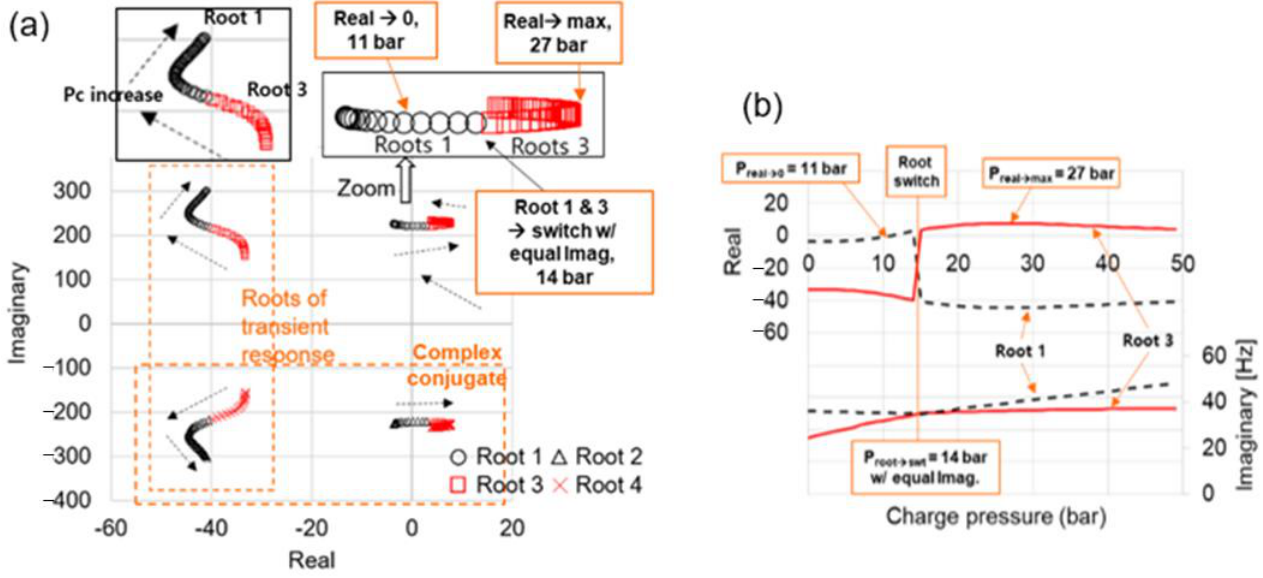
Figure 7. ( a ) Root locus trajectory with charge pressure increasing from 0 to 50 bar for case 3 and ( b ) real and imaginary values of upper poles (roots 1 and 3).